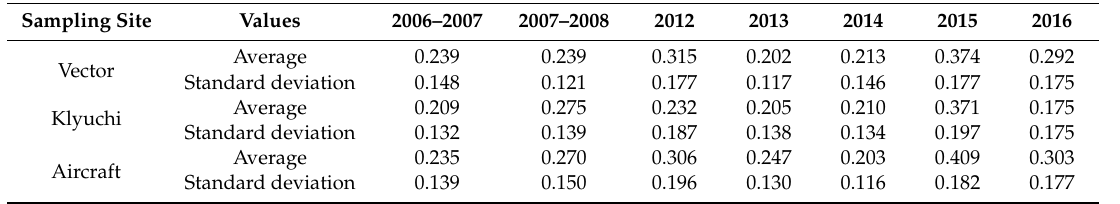
Table 2. Annual average values and standard deviations from them of the integral index of potential pathogenicity of culturable bacteria and yeast in an atmospheric aerosol in the south of Western